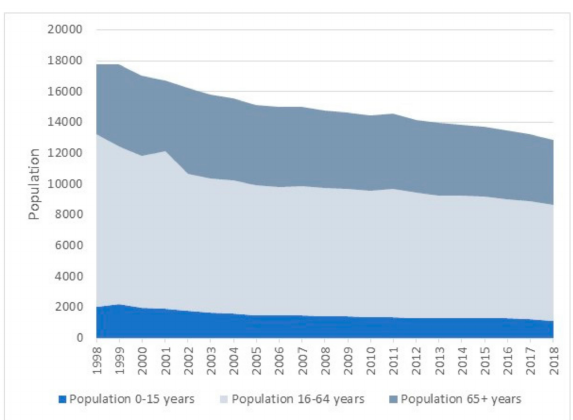
Figure 4. Trend in the population of the Villuercas-Ibores-Jara Geopark since 1998. Source: based on data provided by Spain’s National O ffi ce of Statistics—Instituto Nacional de Estad í